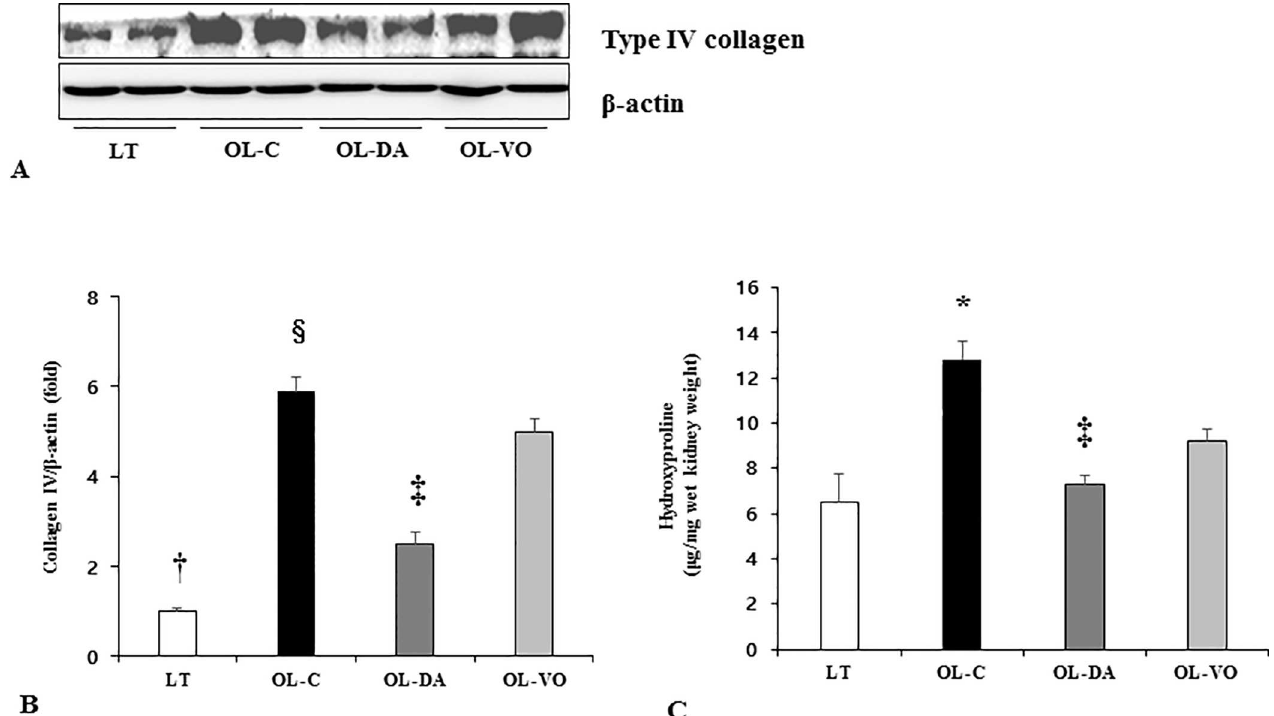
Fig 8. The expression of type IV collagen and total collagen content in renal tissues. (A) Representative immunoblotof type IV collagen,(B) quantitativeanalysesof the expression of type IV collagenand (C) the amount of hydroxyproline in renal tissue in LETO (LT) and OLETF rats with saline (OL-C), dapagliflozin (OL-DA) or voglibose(OL-VO) treatment. * P < 0.05, OL-C vs. other groups; † P < 0.05, LT vs. other groups; ‡ P < 0.05, OL-DA vs. OL-VO; § P < 0.05, OL-C vs. OL-DA. Values are expressedas means ±